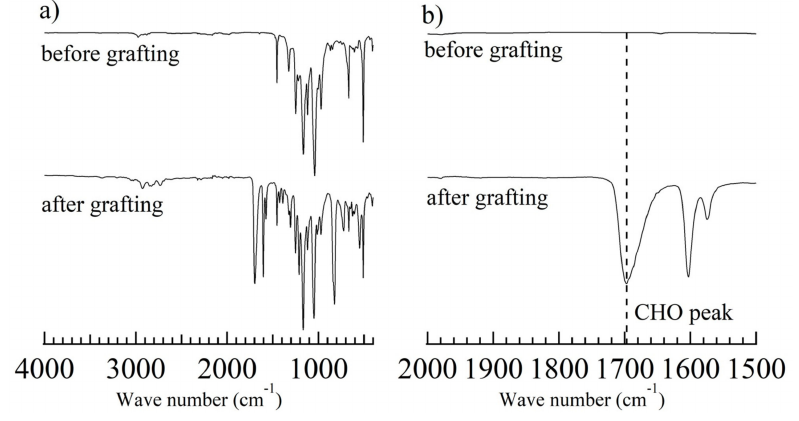
Figure 2. ATR-FTIR spectra ( a ) 400–4000 cm − 1 , and ( b ) 1500–2000 cm − 1 of the ETFE film and ETFE- g -PSt-CHO (grafting time: 3 h).